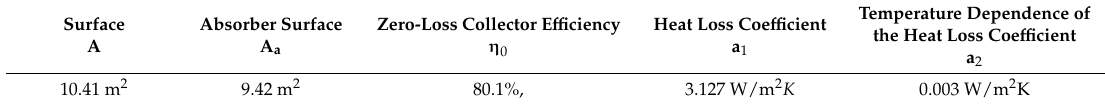
Table 4. Parameters of the solar